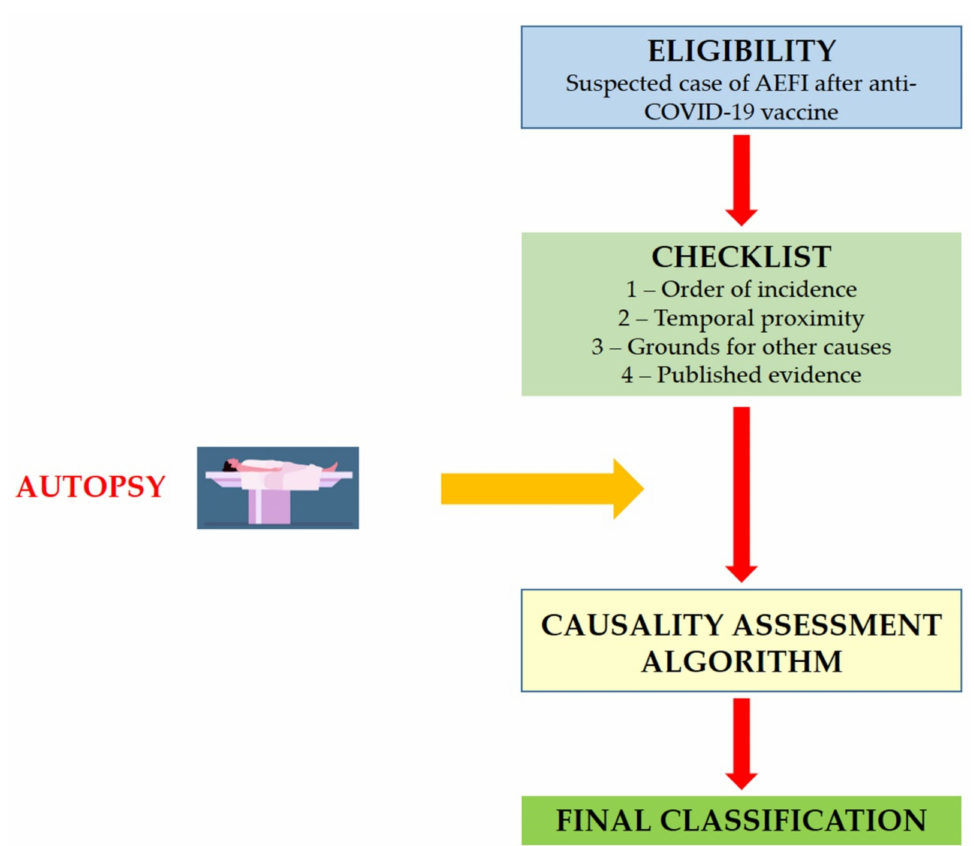
Figure 1. Structure of the causality assessment guidelines for AEFI following COVID-19 vaccine